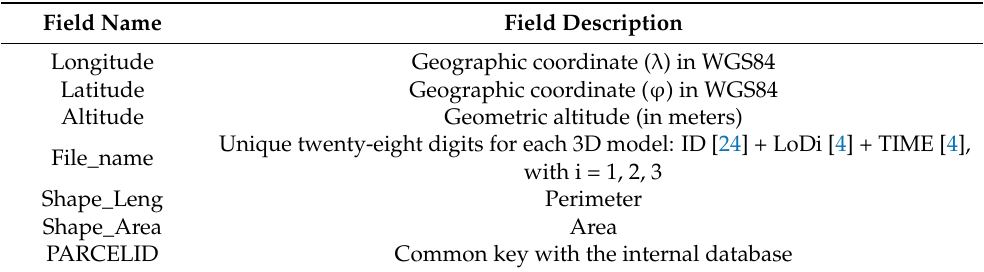
Table 1. Proposed metadata schema in each 3D